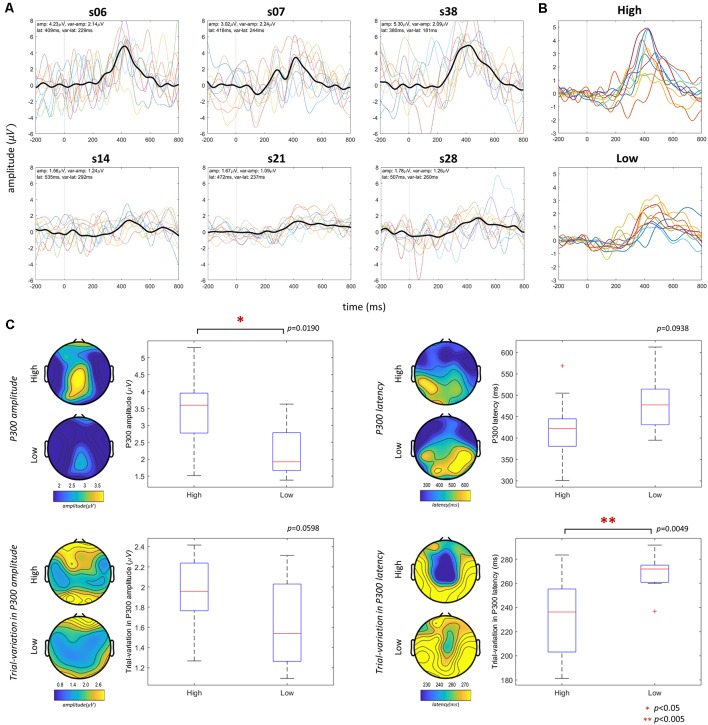
RSVP features of high and low performers. Panel (A) shows three representative waveforms (black bold line) from the top 10 and bottom 10 performers with their single-trial waveforms: thin dashed lines (for visual representation, 10 single-trial waveforms selected randomly were drawn). Panel (B) indicates ERP waveforms of all of the high and low performers. Panel (C) compares group-difference through the scalp topography maps representing the averaged spatial patterns of the RSVP electroencephalography (EEG) features for high and low performers, and the box plots show the statistical difference between high and low performers. The red asterisk denotes statistical significance as shown at the bottom. To compute spatial patterns (scalp topography) and group differences (box plot), single-electrode features and averaged electrode (Fz, Cz, Pz, CP1, and CP2) features were used, respectively.